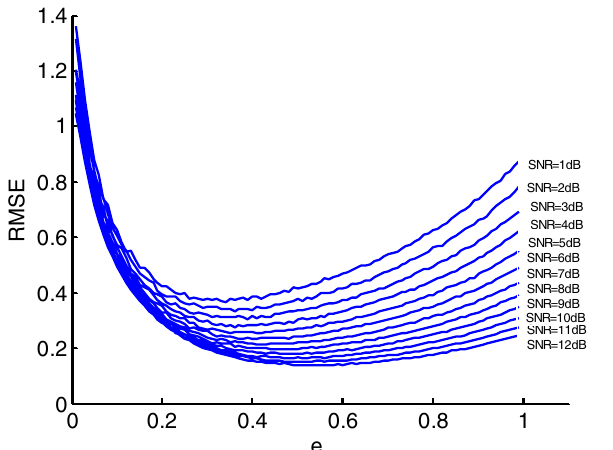
Figure 3. The RMSE of PPS over different e.